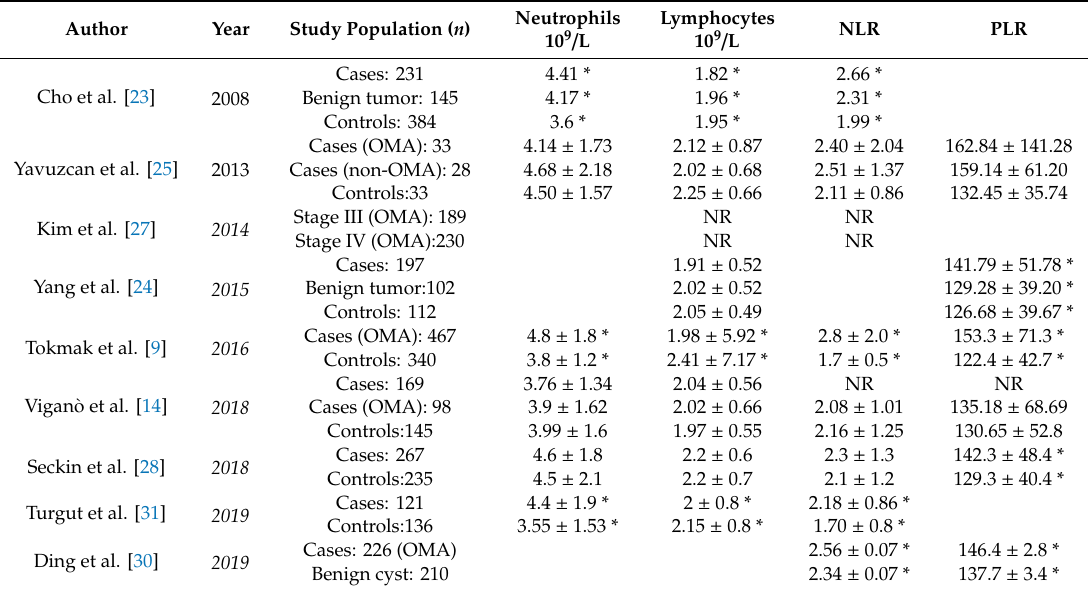
Table 7. Systematic review: inflammatory parameters of women with or without endometriosis in the included